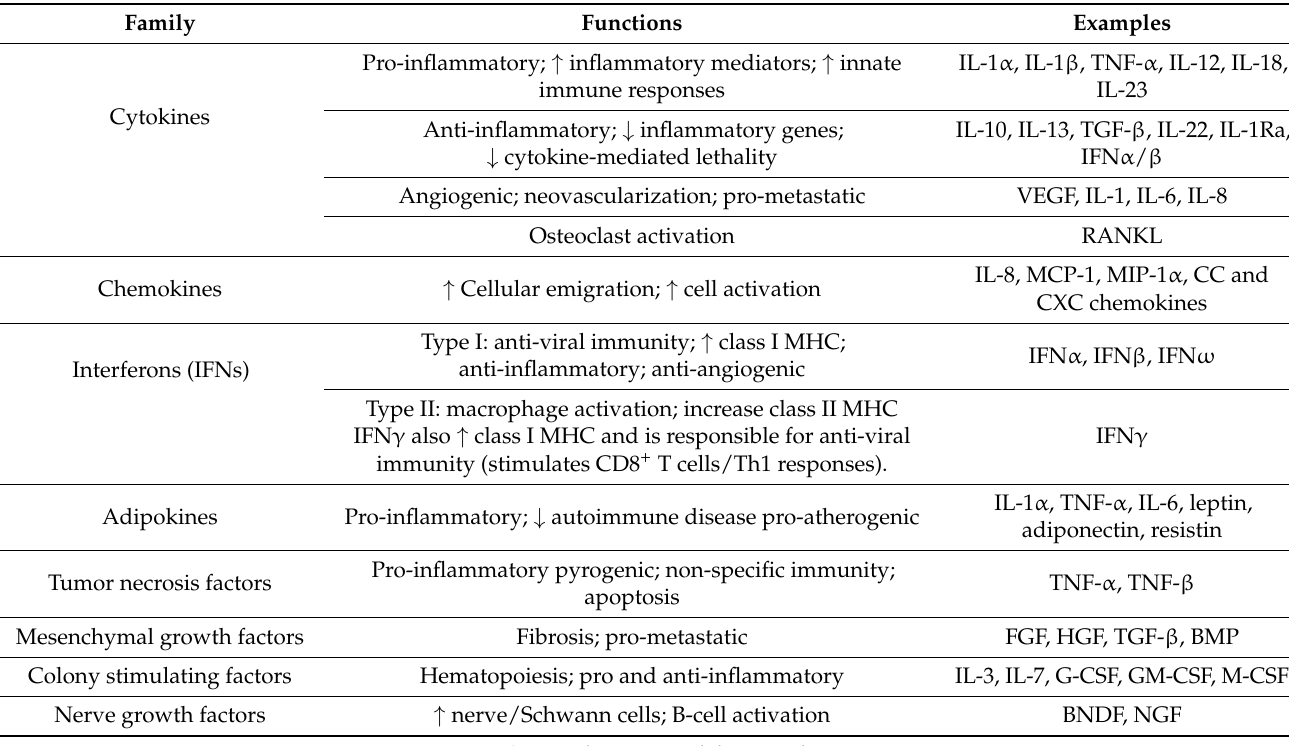
Table 1. Main functions and examples of